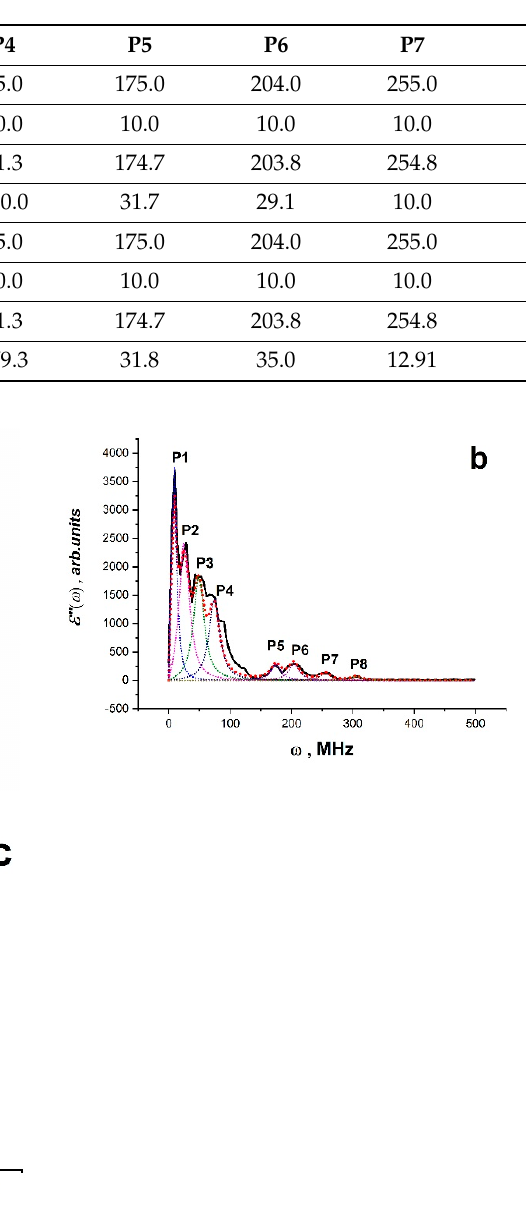
Table 3. Parameters of the radiation bands.